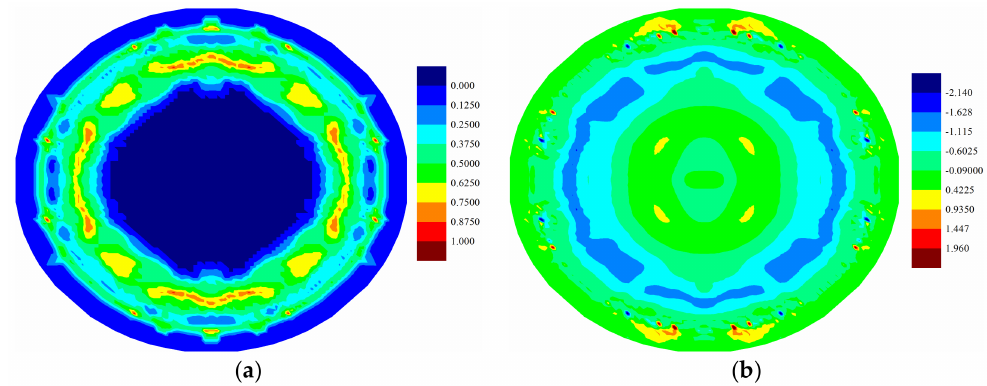
Figure 10. ( a ) Matrix damage and ( b ) temperature change distribution (K) of bottom ply at 0.1538 × 10 − 3 s.